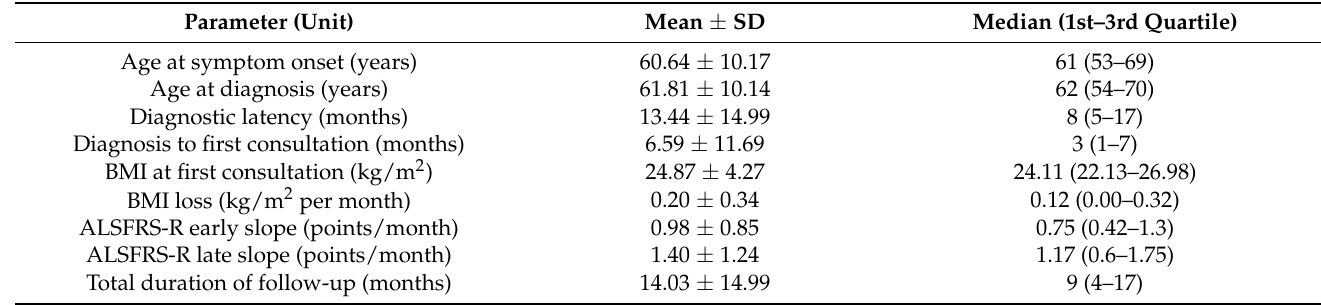
Table 1. General characteristics of the study population ( n =